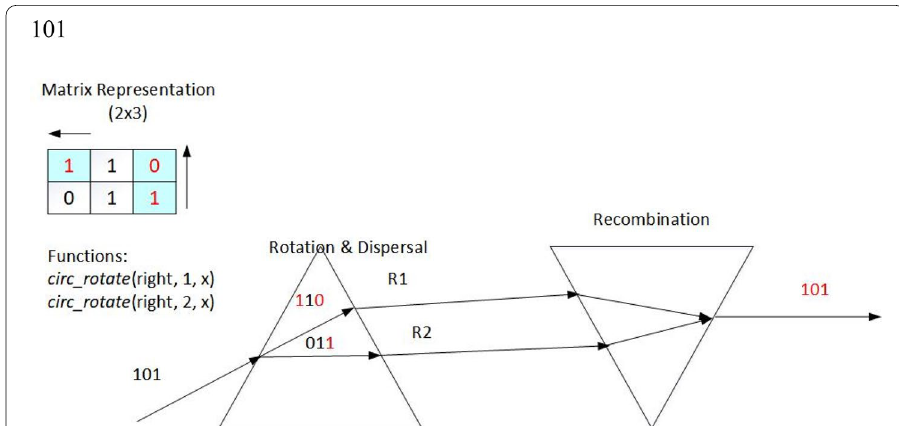
Fig. 9 Passing the classical bit string 101 through the bit prism